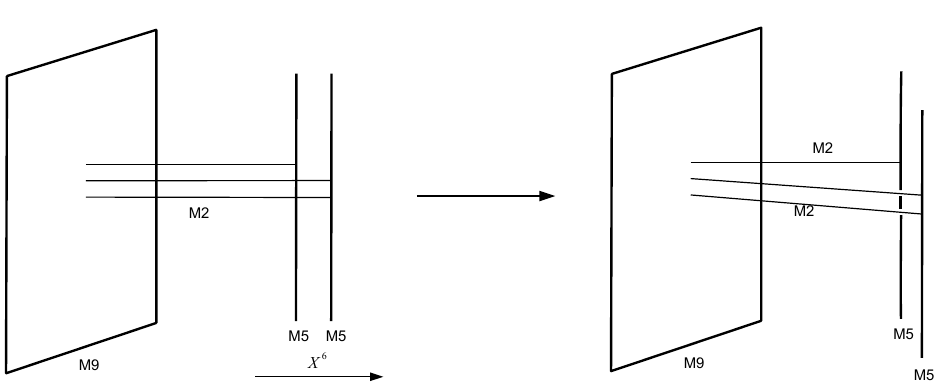
Figure 8 . String charge sector (3 ; 2) for the con(cid:12)guration of two M5 branes probing an M9 wall. In the massless case the strings can recombine and one arrives at a con(cid:12)guration of a single E-string from the (cid:12)rst M5 brane and two E-strings from the second.